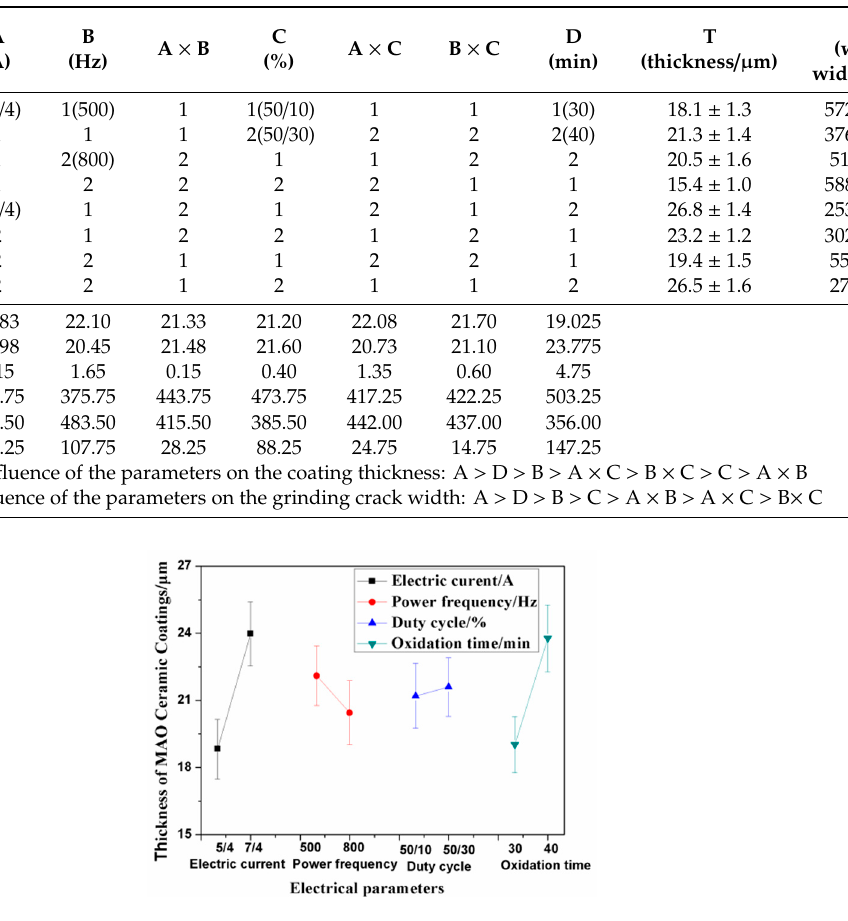
Figure 1. Relationship between the electrical parameters and coating thickness. MAO—micro arc oxidation.